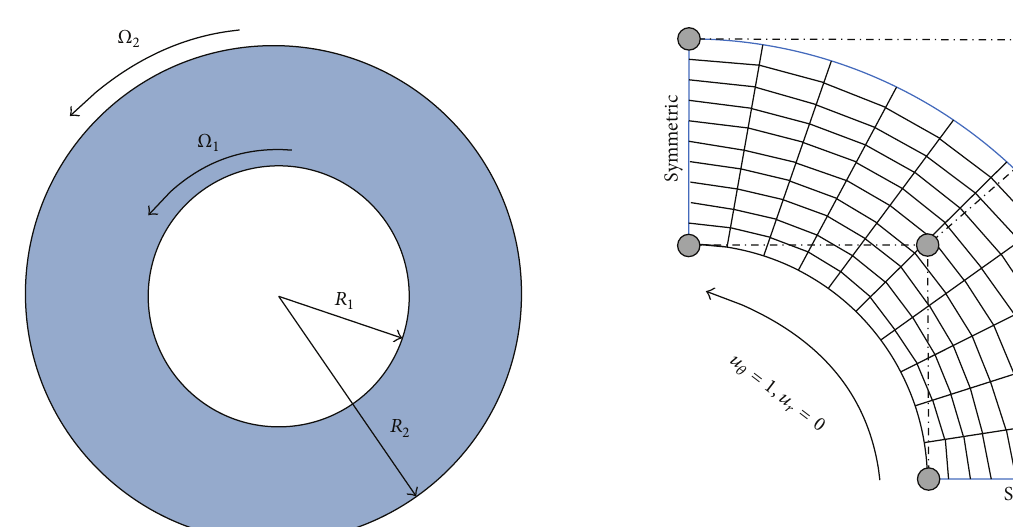
Figure 13: Settings of grid and boundary